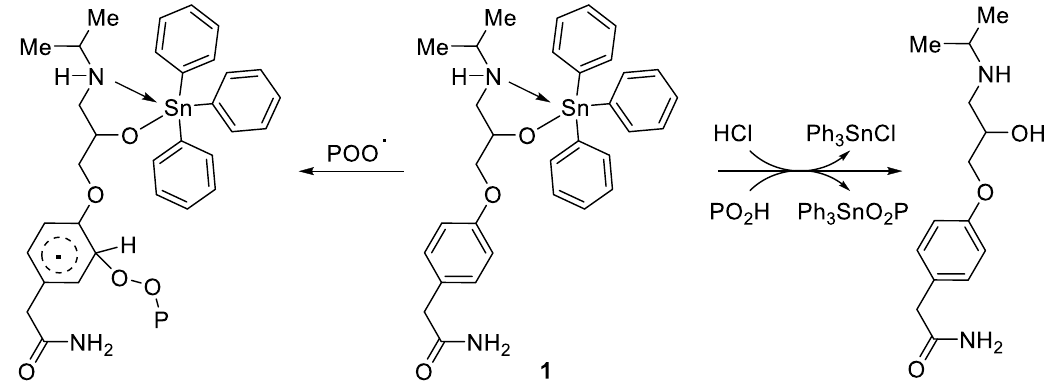
Figure 9. Complex 1 acts as a hydrogen chloride scavenger, hydroperoxide decomposer, and radical absorber.